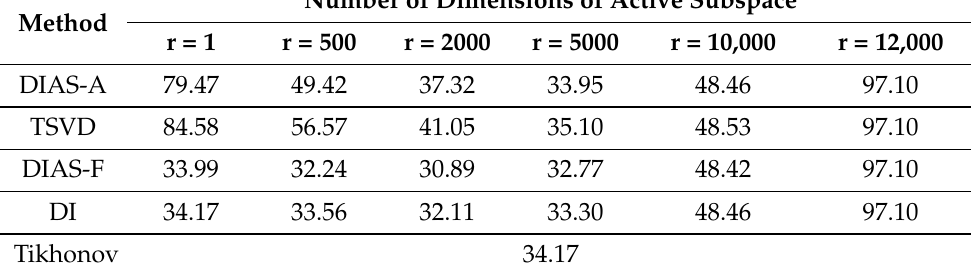
Table 7. Relative error (%) of inverse solutions by DIAS and Tikhonov regularization for underregu- larization case with α = 1.35 × 10 5 , noise level 3%.